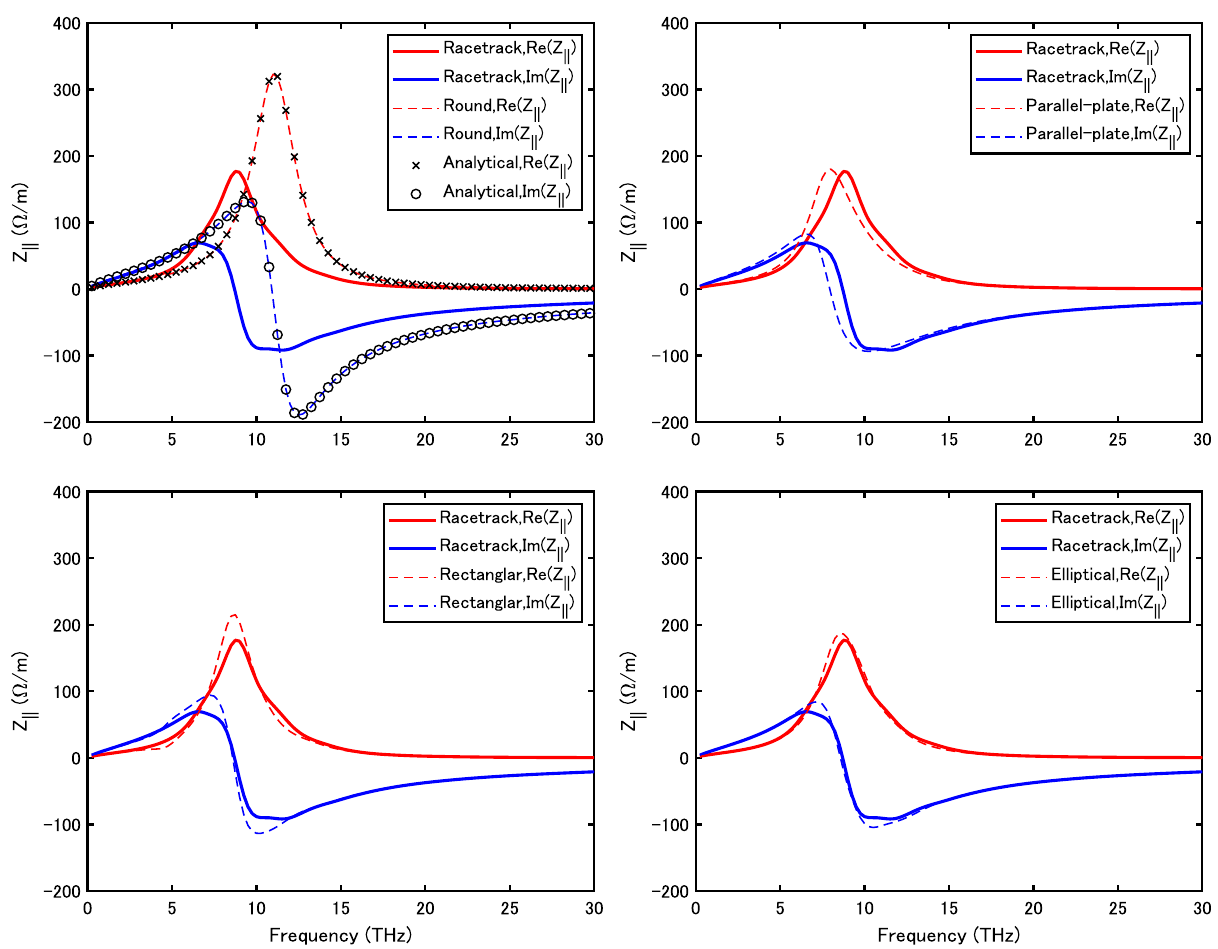
FIG. 9. ASE resistive-wall impedances of an aluminum vacuum chamber of racetrack cross section and those of different cross sections: (top left) round, (top right) parallel plate, (bottom left) rectangular, and (bottom right) elliptical. The parallel plate chamber impedance is calculated with the analytical formula in Refs. [8,50]. For a numerical verification, the analytical impedance [8] is also displayed for the round